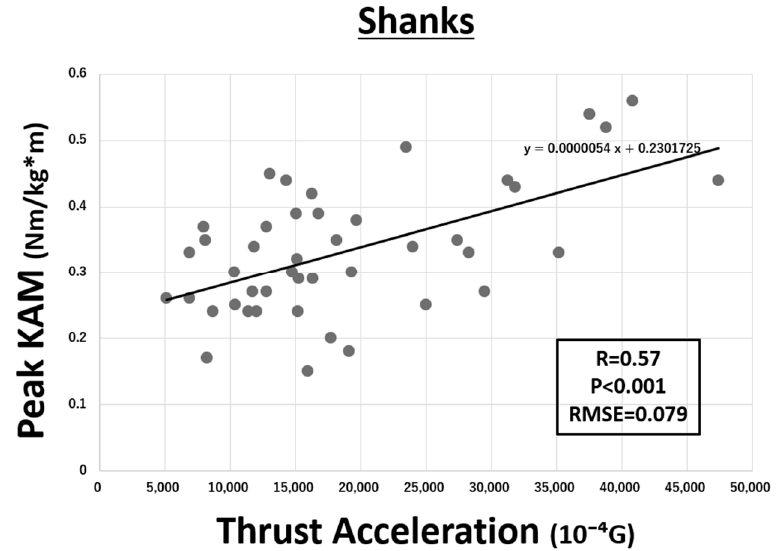
Figure 5. Correlation between peak knee adduction moment (KAM) and thrust acceleration (TA) on both shanks (R = 0.57, p < 0.001). The root mean square error (RMSE) was 0.079 Nm/(kg · m) (G = 9.81 m/s 2 ).